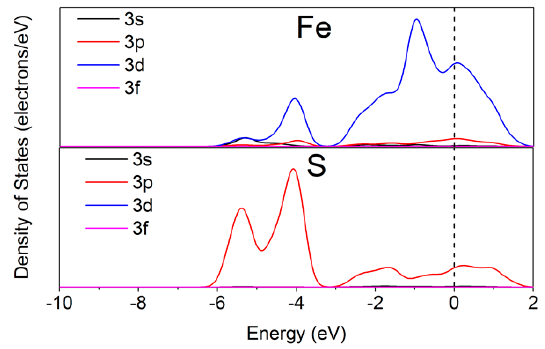
Figure 5. Partial density of states of chalcopyrite (001)-S surface.